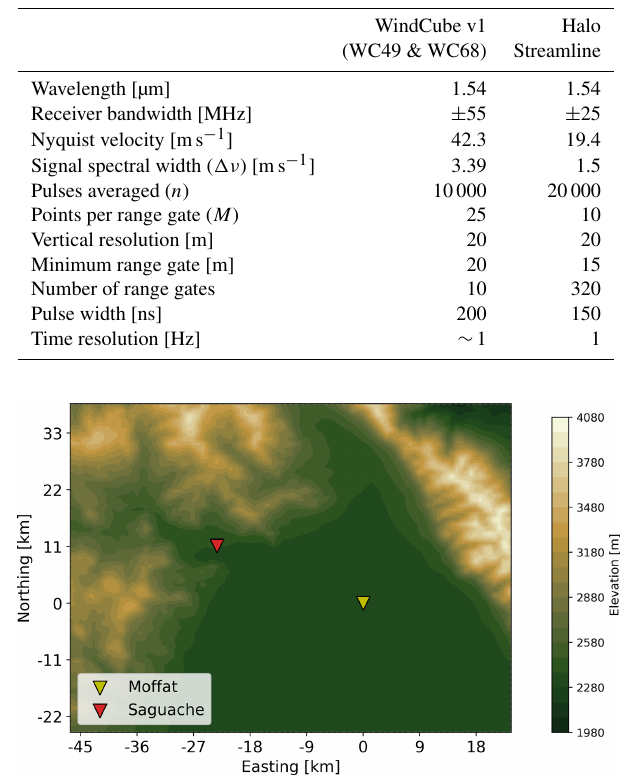
Table 1. Main technical specifications of the lidars used in this study.